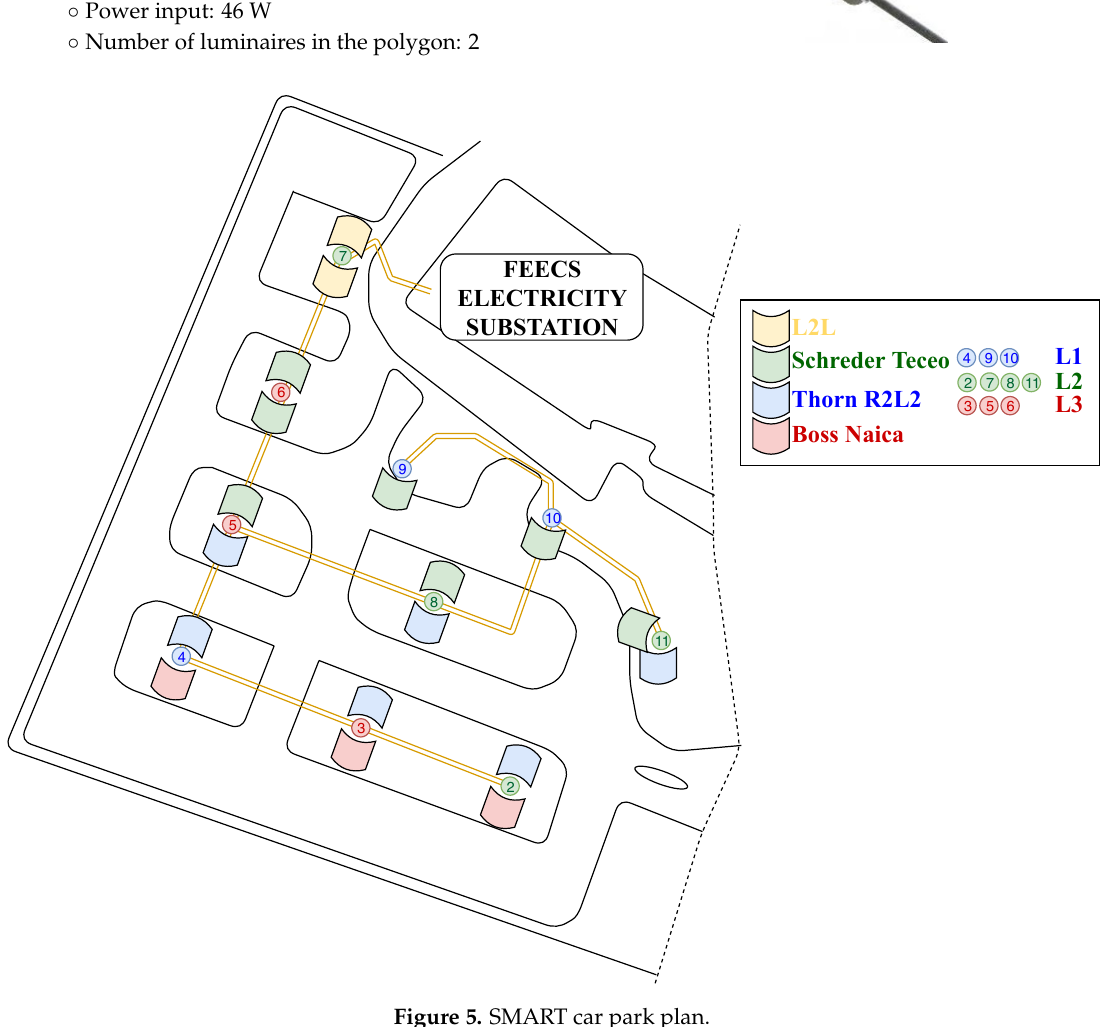
Figure 5. SMART car park